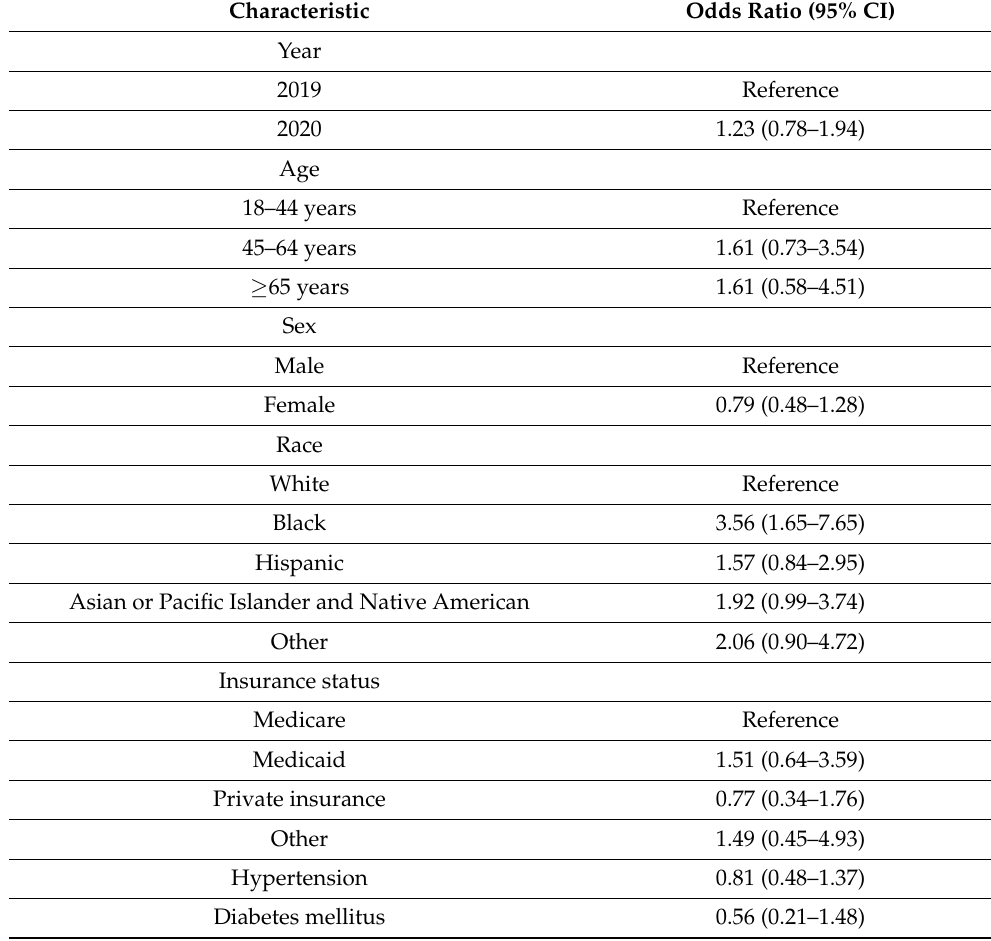
Table 3. Factors associated with Clavien–Dindo grade IV complications and in-hospital